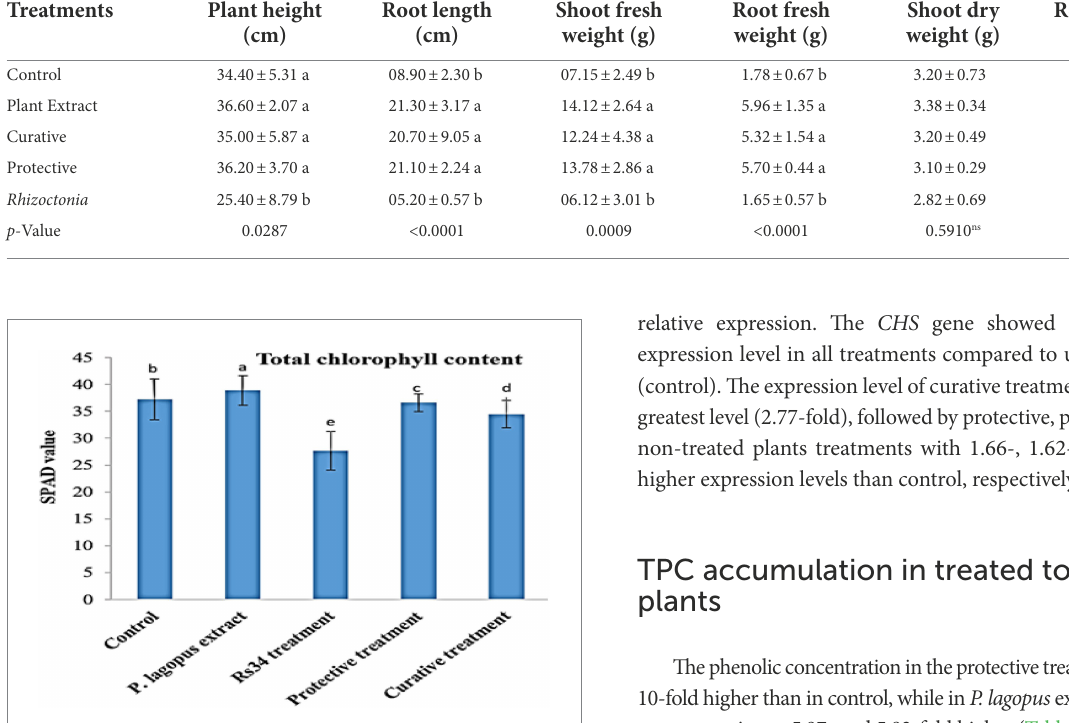
FIGURE 3 Effect of all treatments on total chlorophyll content (SPAD value) in tomato plants as affected by root rot disease under greenhouse conditions. The different letters (a–e) represent significant